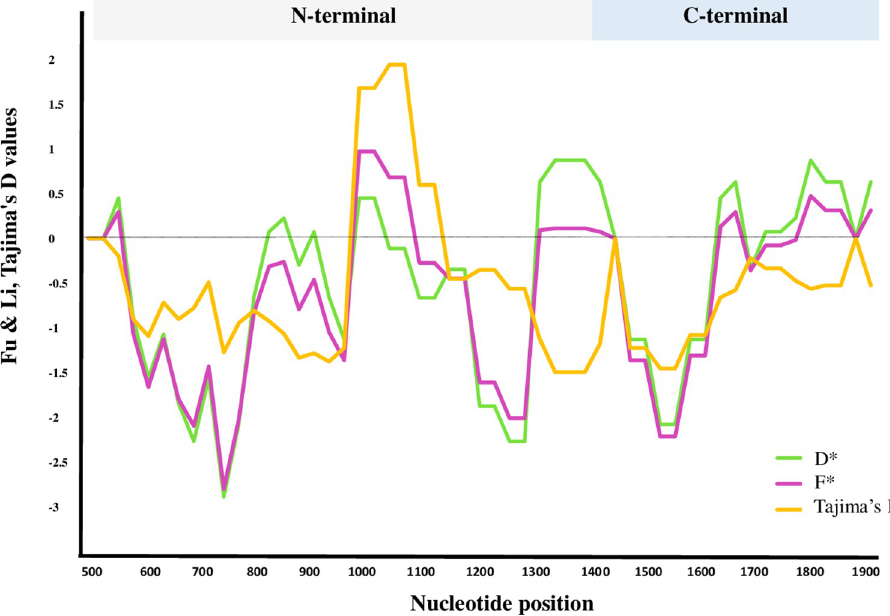
Fig 2. Tajima’s D, Fu and Li’s (D � & F � ) values for global sequences of pvrbp2b . The values are measured on a sliding window of 100 bp and a step size of 25 bp to assess the stepwise diversity of worldwide dataset ( � , P < 0.05). Nucleotides were numbered according to Sal-I reference sequence